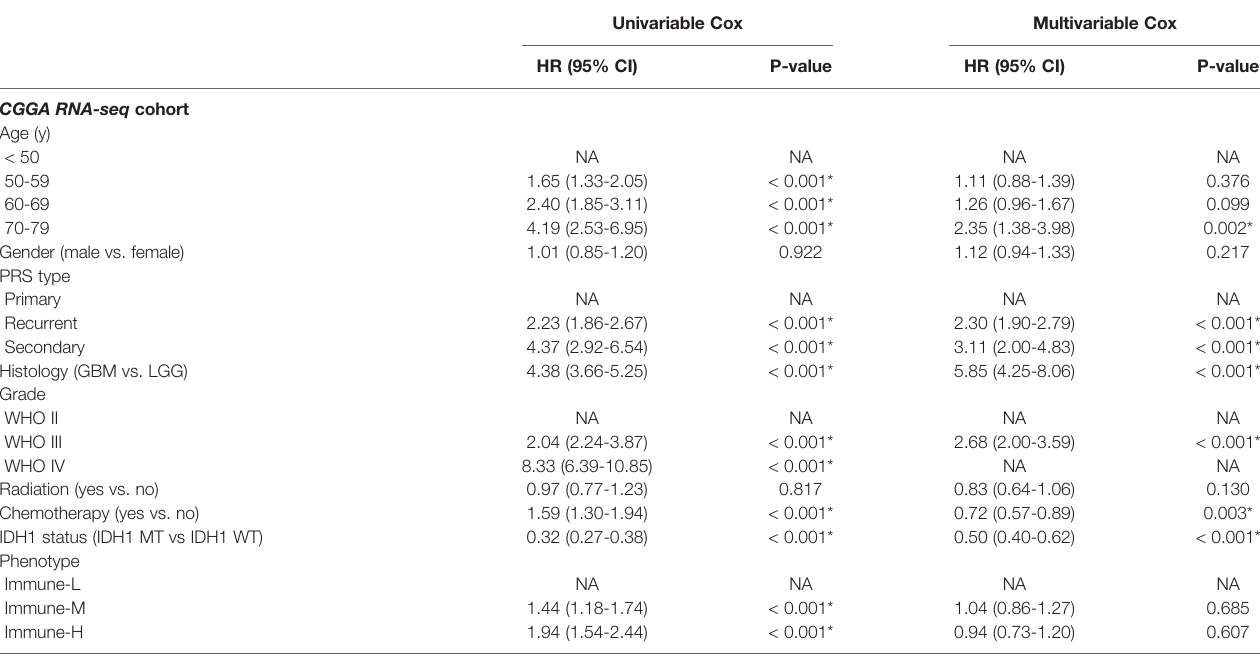
other molecular and clinicopathological factors is being warmly discussed in glioma, and more evidence is needed in the